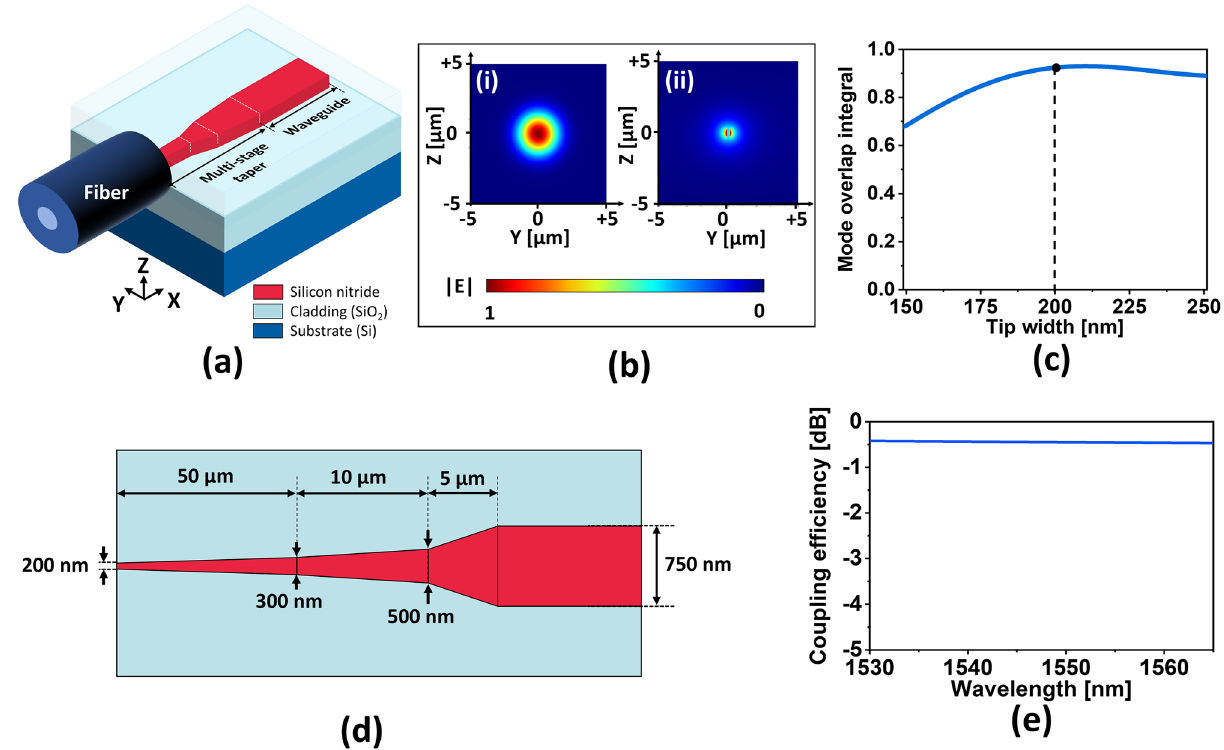
Figure 6. ( a ) Proposed end-fire coupler based on an SSC comprising a multi-stage taper. Calculated guided mode profiles of the ( b )–(i) high-numerical-aperture fiber and ( b )-(ii) the taper terminated with a 200-nm-wide tip. ( c ) Calculated mode overlaps between the fiber and taper tip in terms of the tip width. ( d ) Designed multi- stage taper consisting of three serially concatenated segments and ( e ) spectral coupling efficiency of the end-fire coupler based on the designed